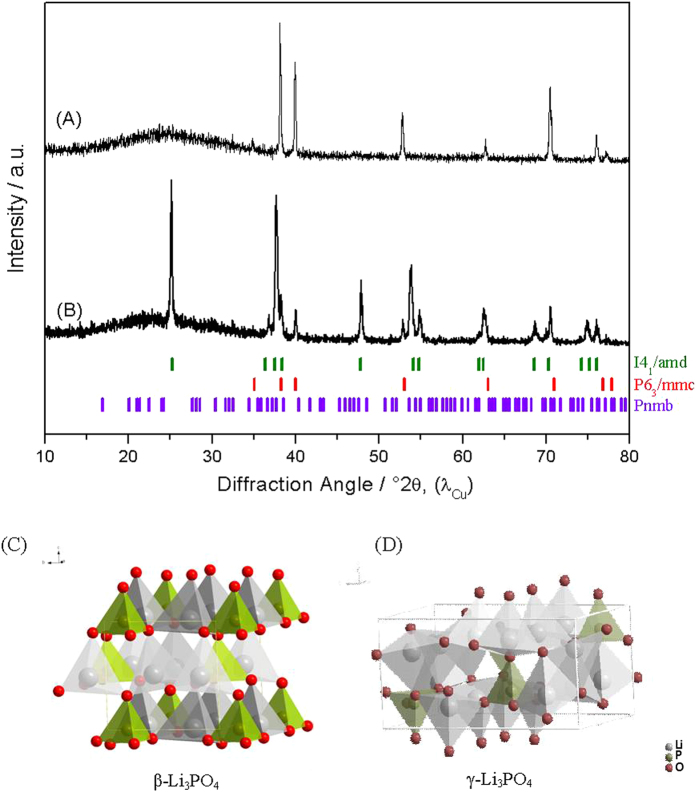
XRD patterns of Li3PO4-coated TiO2 anode (A) as-prepared and (B) after thermal annealing at 500 °C in air for 2 h. (C,D) show representations of the crystal structure of β-Li3PO4 and γ-Li3PO4, respectively.